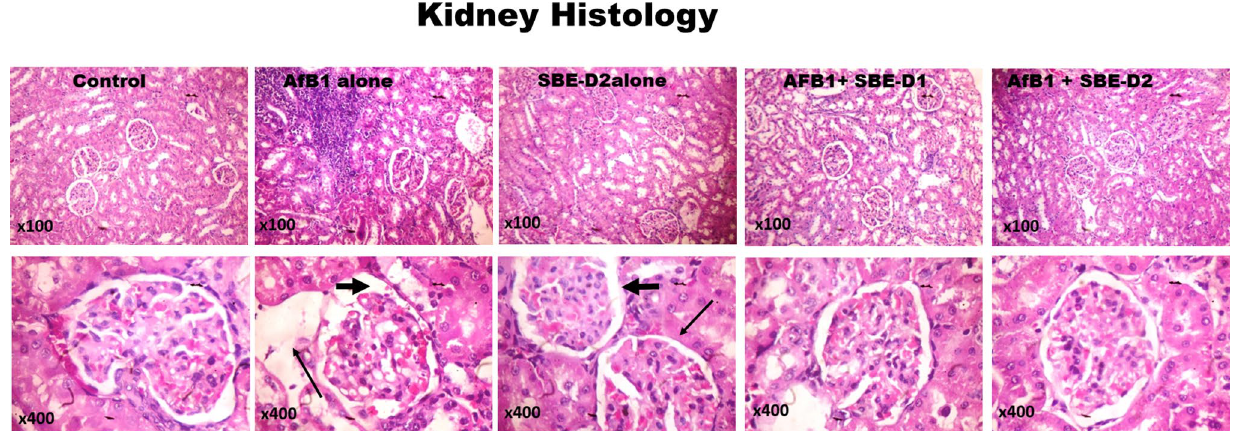
Figure 10. Control plates of the kidney; shows typical architectural features of the kidney tubules devoid of visible lesions. AFB 1 alone plates show disseminated glomerular messangialisation (thin arrow) and extensive area of infiltration of the cortex by inflammatory cells (bold arrowhead). SBE-D2 plate tissues appear normal and relatively like those from control tissue sections. AFB 1 with SBE-D1 and SBE-D2 plates dose-dependently improved histo-architecture of the kidney with the mild presence of the inflammatory cell. H and E-stained sections; Magnification at × 100 top panel; × 400 lower